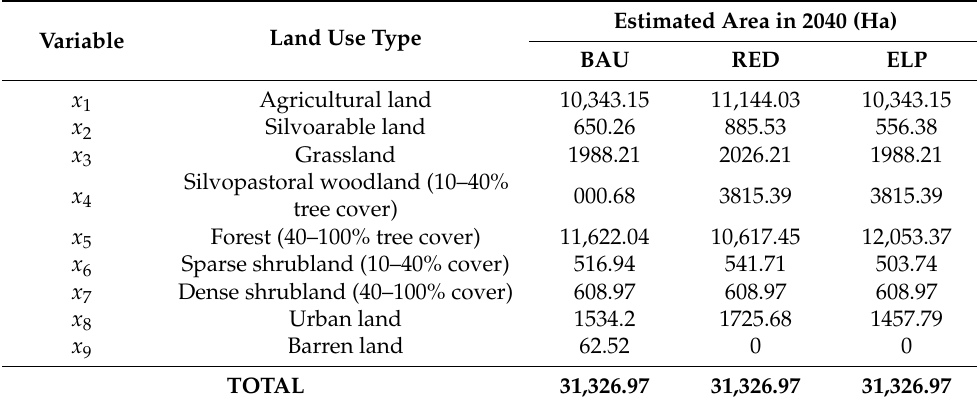
Table 6. Estimated area in 2040 (Ha) under the three scenarios (BAU, RED, ELP).